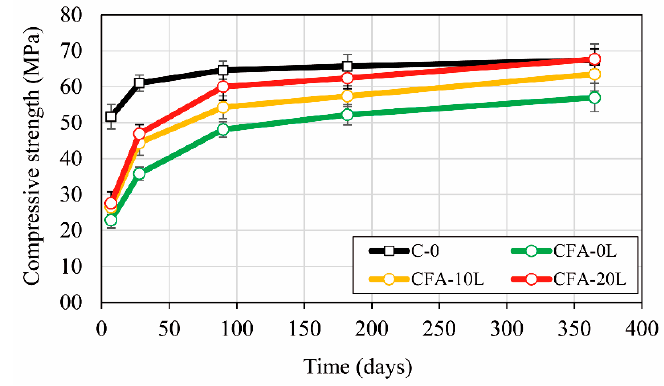
Figure 5. Evolution of concrete compressive strength.